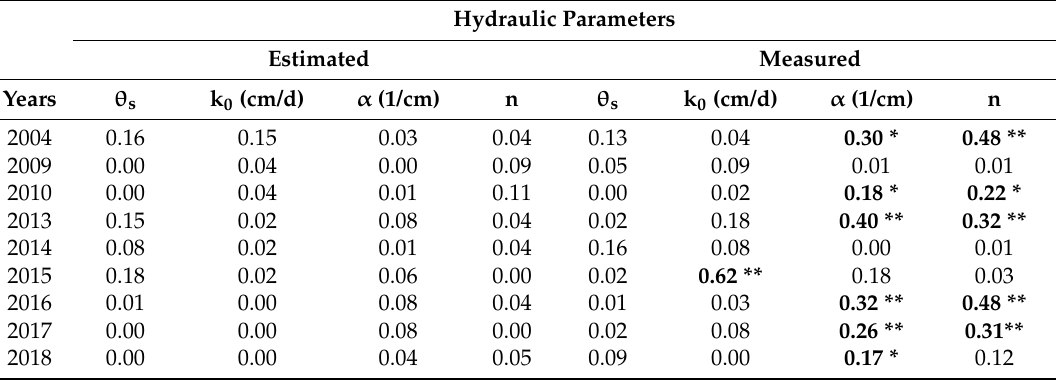
Table 3. Square of the correlation coefficients (r 2 ) between measured and estimated hydraulic parameters vs NDVI estimated by Landsat-8 images.